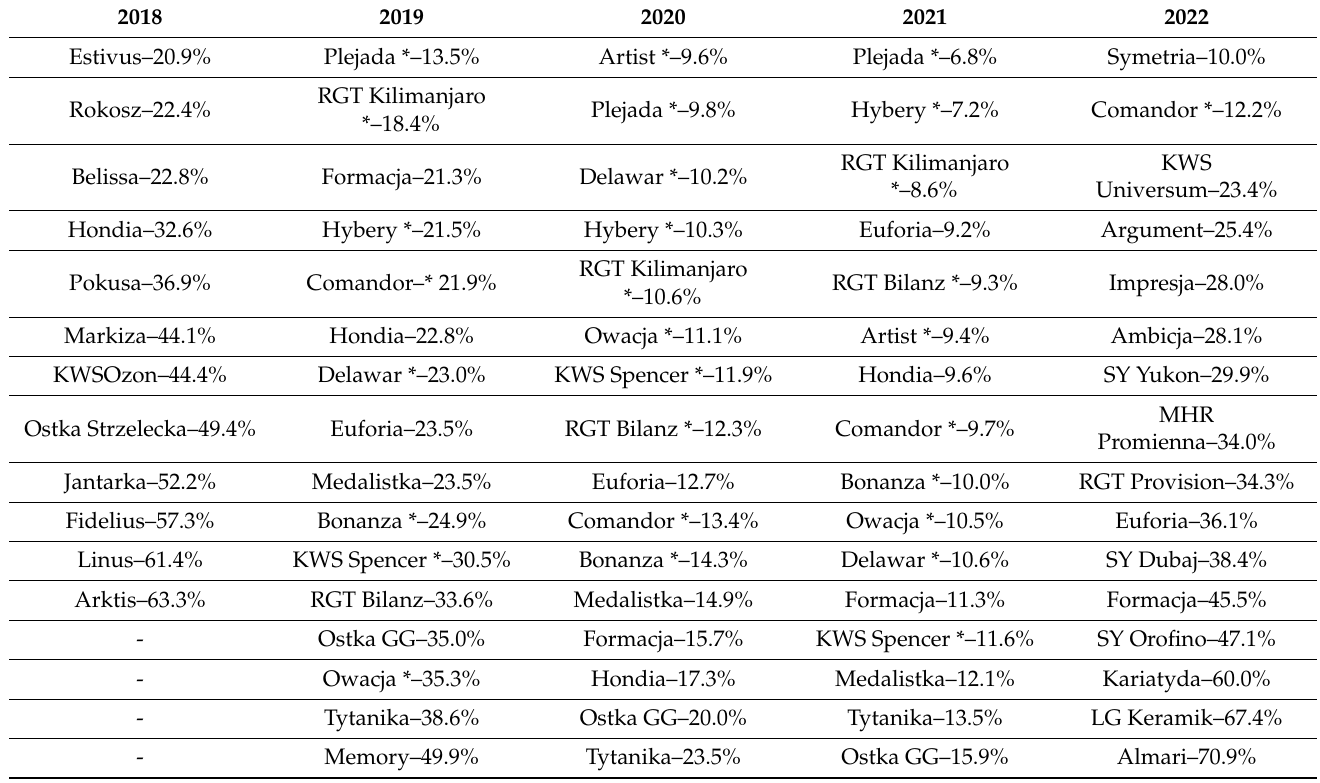
Table 8. Average fungal disease infestation on a flag leaf of different varieties of winter wheat in different